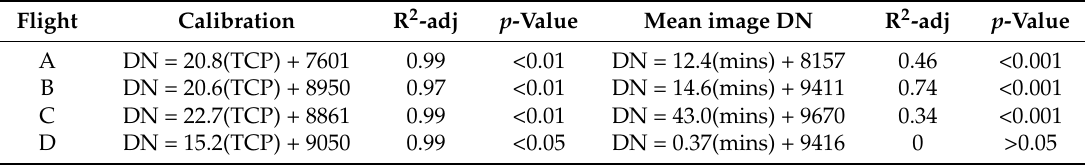
Figure 7. Empirical line calibrations using measured TCP temperatures (red circles) for Flights A–D ( a – d , respectively), error bars denote ± σ . Horizontal error bars are ≤ 0.9 °C and vertical error bars are <42 DN. Mean digital number values over the duration of the flight for Flights A–D ( e – h , respectively), including linear regression line (dashed orange line). Note that ( e ) uses the left y-axis but that ( f – h ) use the right y-axis and flight duration varies for plots ( e ) to ( h ). Table 2. Linear regression for calibration of TCP temperature against DN (‘Calibration’) and linear regression of mean image DN against flight duration (in minutes, ‘Mean image DN’), for the four UAV flights. Number of TCPs used for the calibration regressions are listed in Table 1. Sample size (i.e. number of images) used for the ‘Mean DN’ regressions are n = 538 (Flight A), n = 134 (B), n = 53 (C) and n = 80 (D).